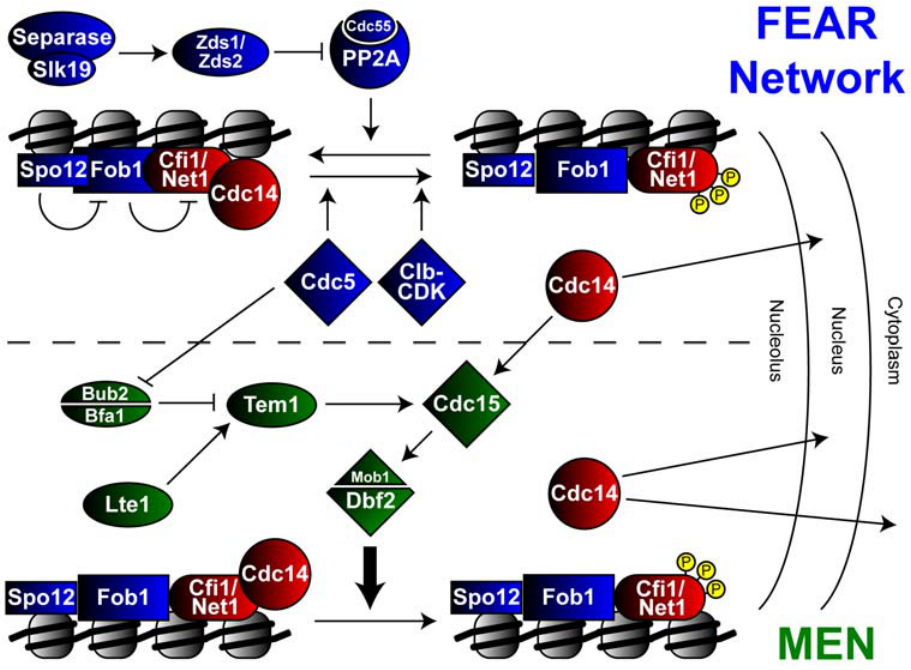
Figure 1. Regulation of Cdc14 release by the MEN and FEAR network. See Introduction for description.